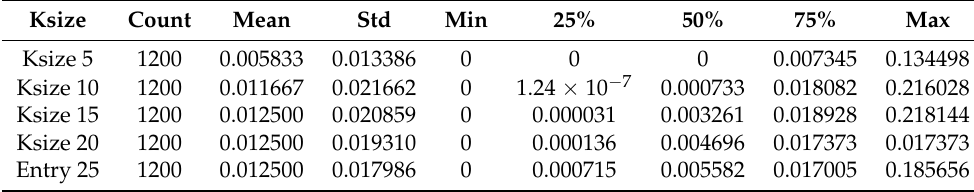
Table 2. Statistics for different ksizes generated according to the boxplot in Figure